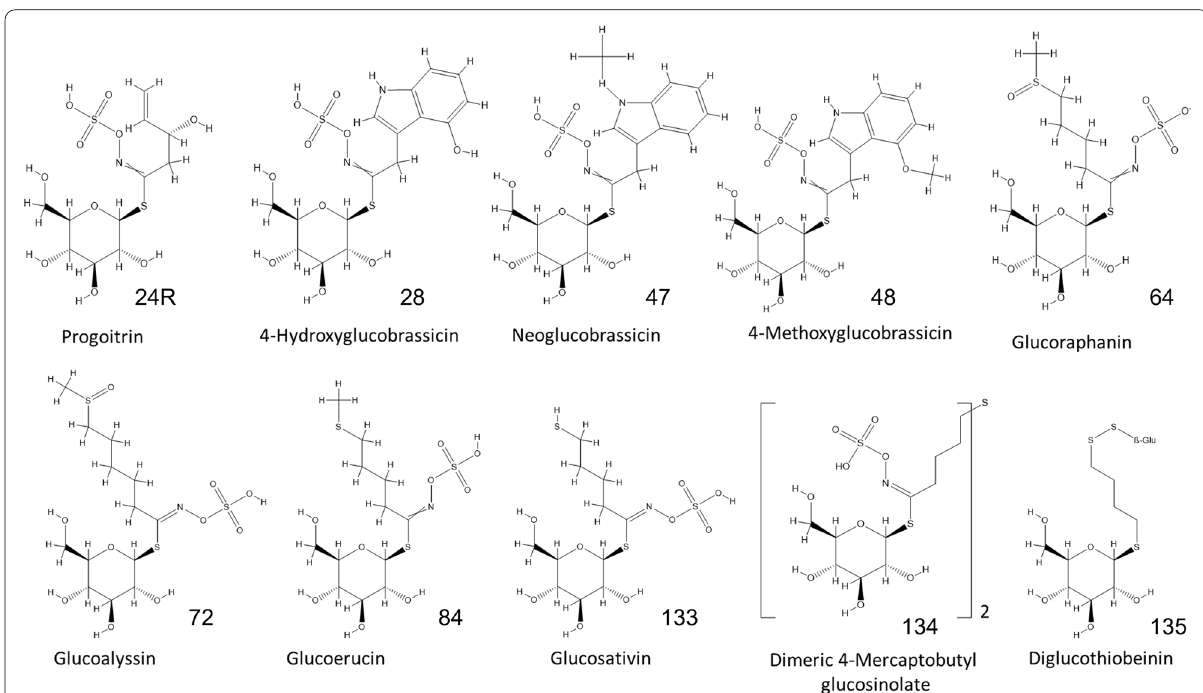
Fig. 1 Chemical structure of glucosinolate compounds found in Eruca vesicaria subsp. sativa leaves. Inset numbers refer to those assigned by Blažević et al.